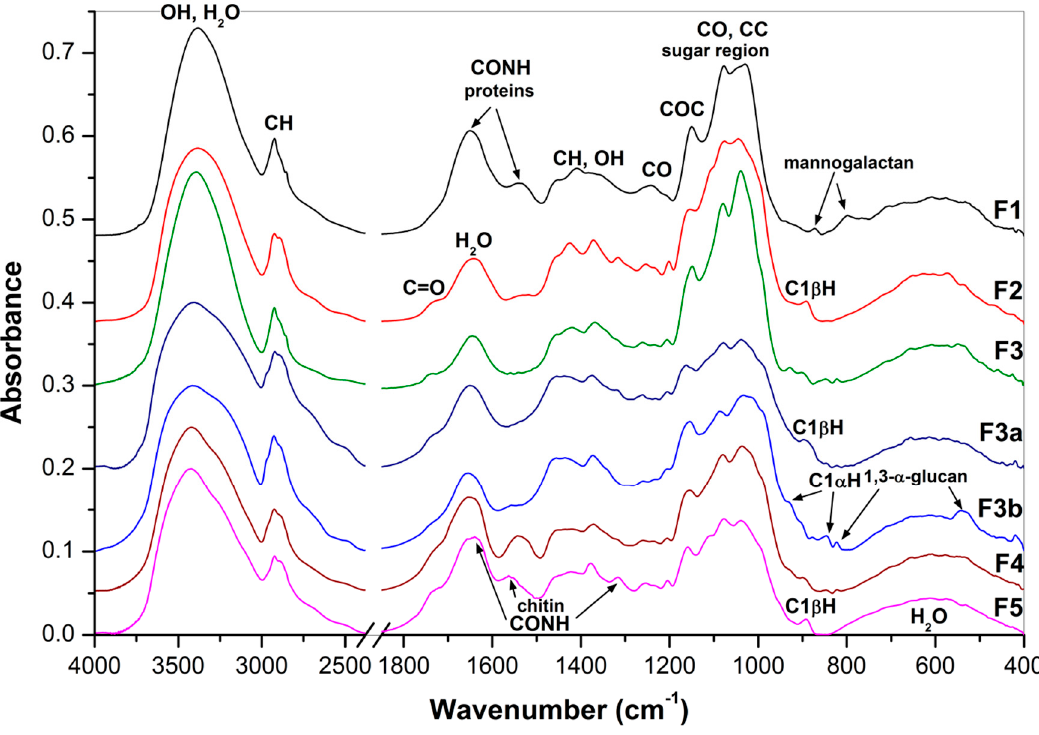
Figure 1. FTIR spectra of the polysaccharidic fractions F1–3, F3a, F3b, F4 and F5 .